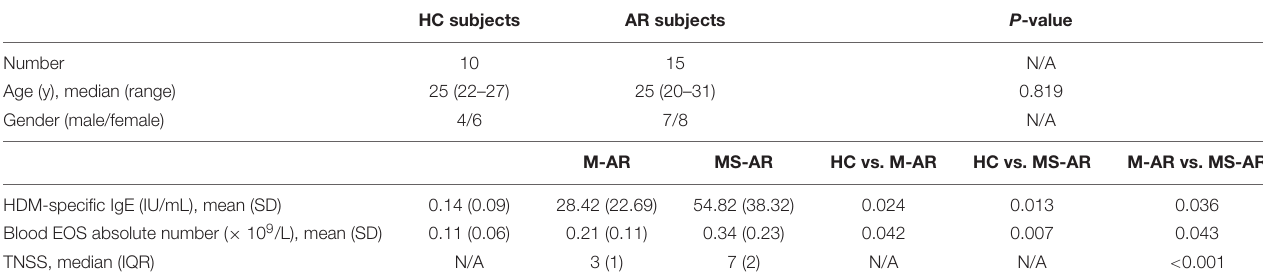
TABLE 1 | Clinical characteristics of HC and AR